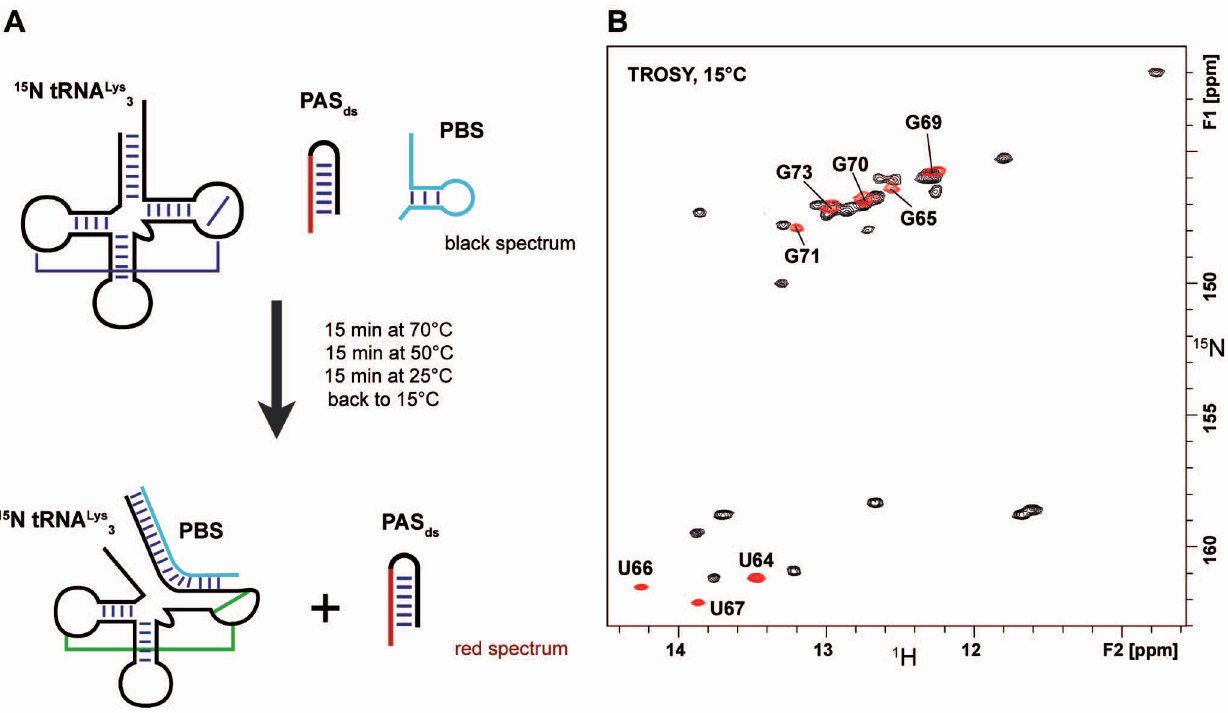
Figure 6. Test of annealing of PAS ds to tRNA Lys 3 in presence of the PBS using the heat-annealed procedure. A) Schematic drawing of the annealing procedure, B) Superimposition of two TROSY experiments recorded at 15 u C showing the imino groups of tRNA Lys 3 alone (in black, reference spectrum) and after the heat-annealed procedure with 1 equivalent of PBS and PAS ds (red spectrum).